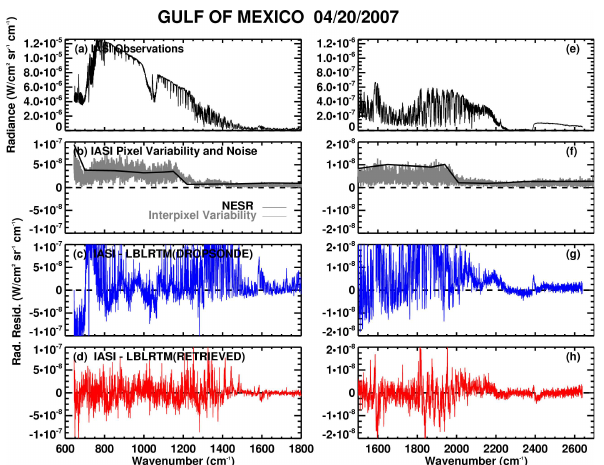
Fig. 4. (a, d) IASI measured spectrum in radiance for the ocean case. (b, e) Spectra showing the variation within the four pixels averaged to obtain the measurement vector. (c, f) IASI/LBLRTM comparison for full IASI wavenumber range with initial guess in- put. (d, g) Comparison after retrievals of atmospheric temperature, H 2 O, O 3 , CH 4 , CO, OCS and HNO 3 . Note different scales on left and right in order to better present the lower radiance at the higher